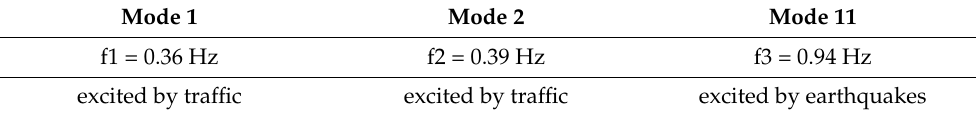
Table 2. Characteristic modal frequencies of the Evripos suspension Bridge, Greece. Based on [24].